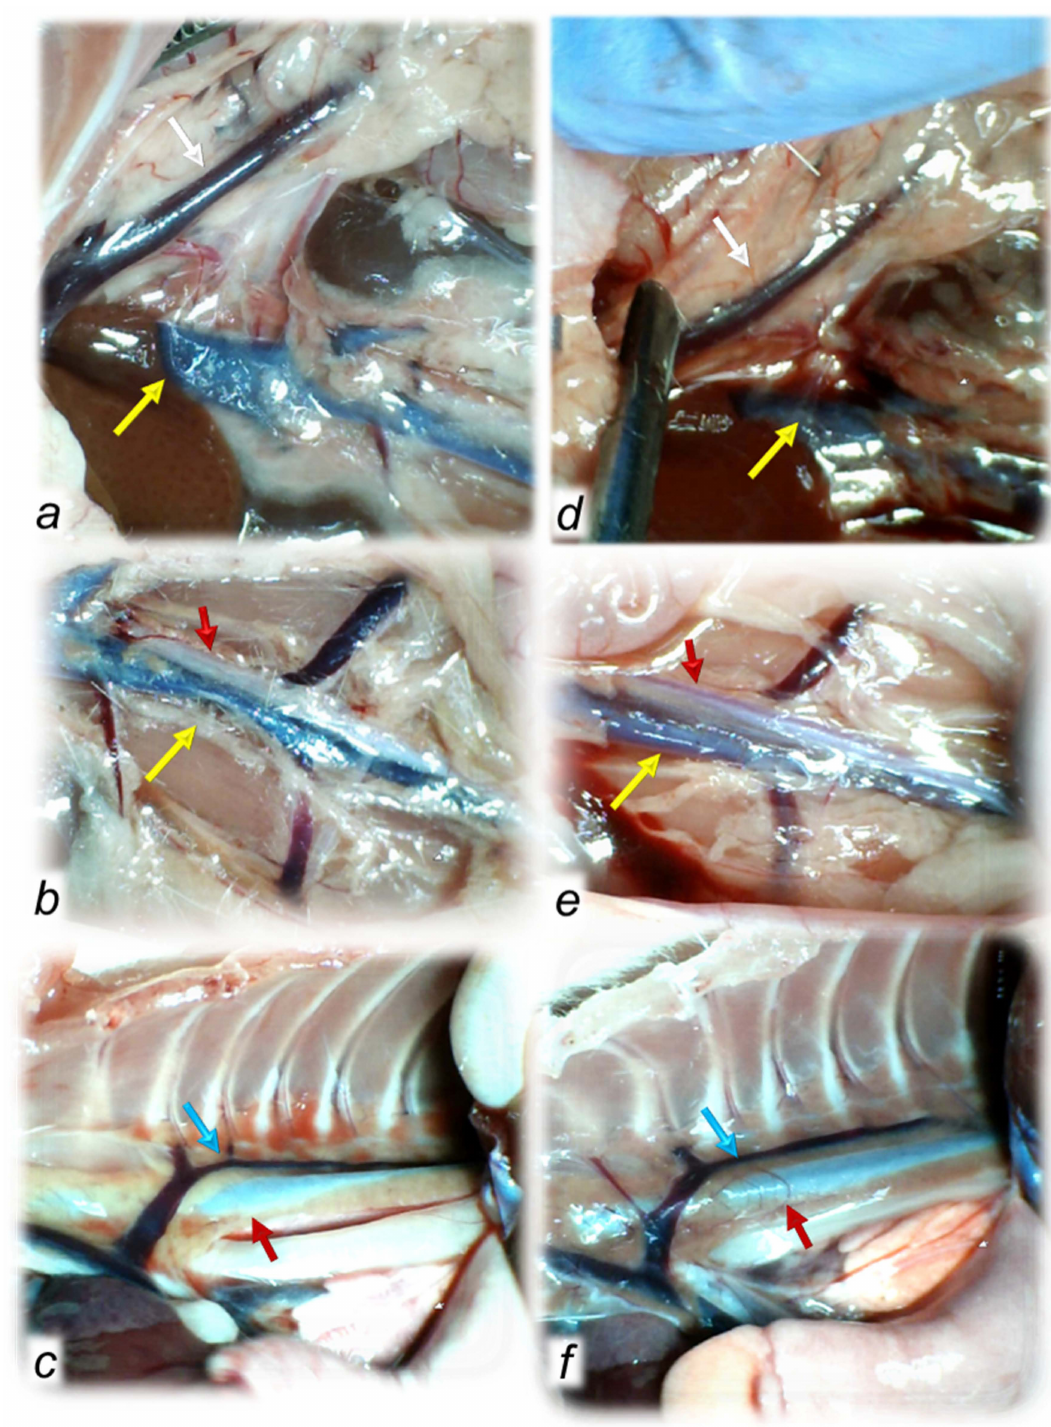
Figure 2. Regular timeline (30 min after isoprenaline) of vessel presentation in the isoprenaline- treated rats, disturbed (congested or collapsed) in controls ( a – c ) and normalized in BPC 157-treated rats ( d – f ), including the superior mesenteric vein (white arrows), inferior caval vein (yellow arrows), azygos vein (blue arrows) and thoracic and aorta (red arrows). Upon BPC 157 therapy, recruitment of the defensive pathways counteracted congestion of the superior mesenteric vein and inferior caval vein and counteracted failure of the azygos vein and thoracic and abdominal aorta timeline ( d – f